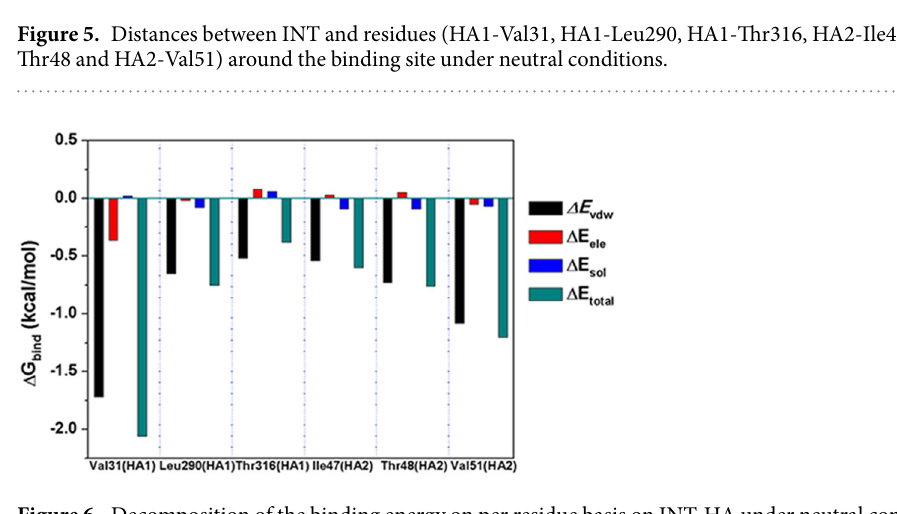
Figure 6. Decomposition of the binding energy on per residue basis on INT-HA under neutral